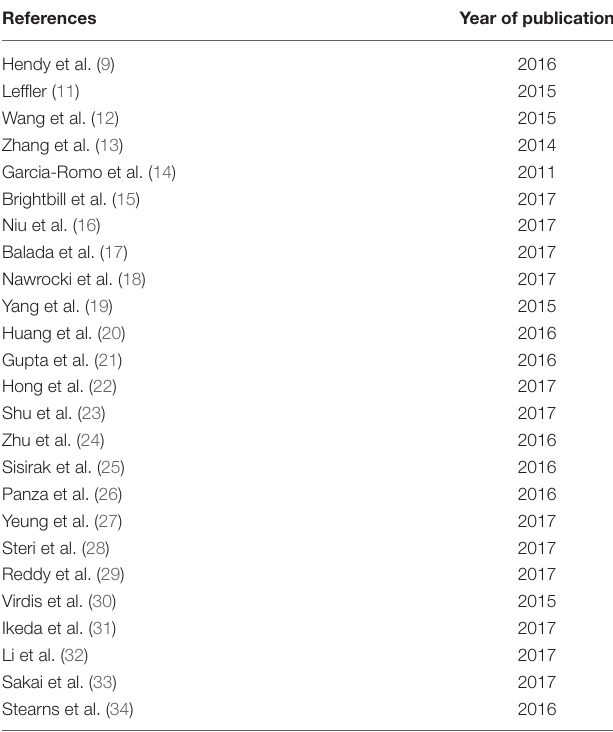
TABLE 1 | Retrieved articles selected for